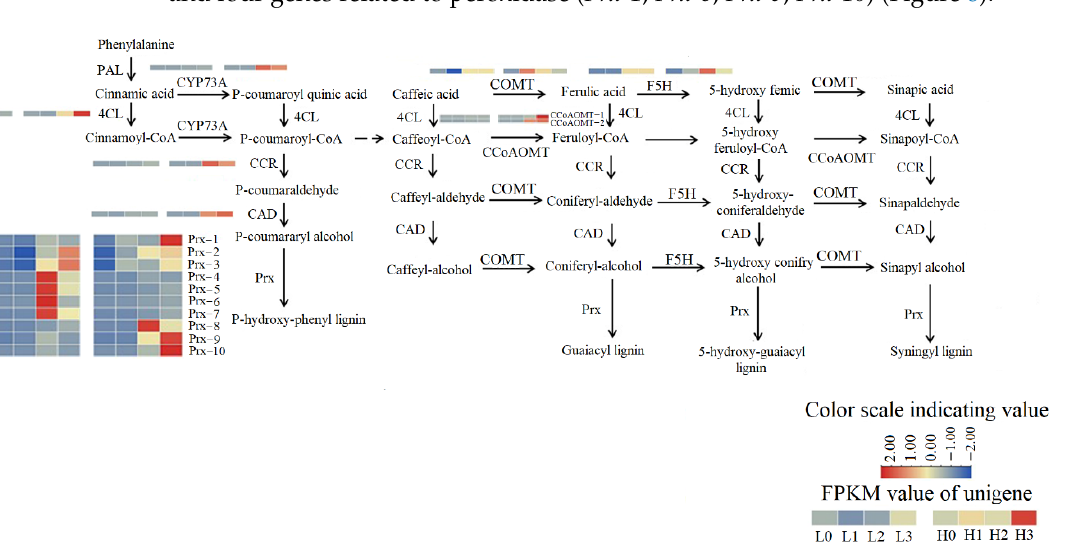
Figure 8. Lignin synthesis pathway. FPKM value of unigenes of the enzymes are indicated from blue to red (low to high) across stage 0, stage 1, stage 2, and stage 3 under low R/FR ratio (L0, L1, L2, and L3) and high R/FR ratio (H0, H1, H2 and H3). PAL: phenylalanine ammonia-lyase; CYP73A: trans-cinnamate 4-monooxygenase; 4CL: 4 coumarate CoA ligase; Prx: peroxidase; CCR: cinnamoyl CoA reductase; CAD: cinnamyl-alcohol dehydrogenase; COMT: caffeic acid 3-O-methyltransferase; CCoAOMT: Caffeoyl-CoA O-methyltransferase; F5H: